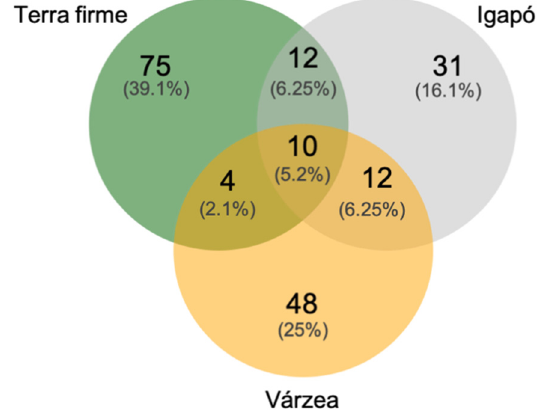
Figure 3. Venn diagram of the number and percentage of species exclusive to or shared between each forest type at Uauaçu Lake, central Amazonia, Brazil.